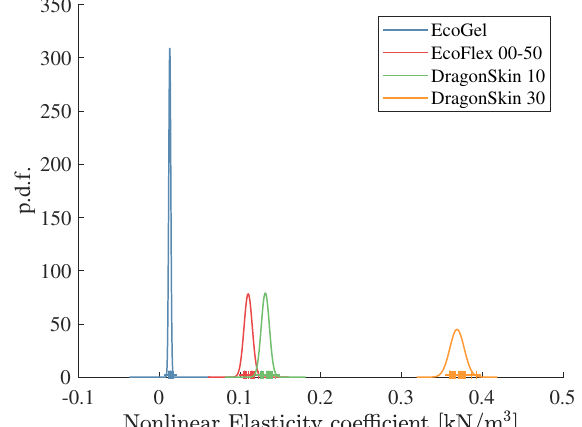
Figure 5. Estimation of the nonlinear elasticity coefficients k nl in model (4) for the four different rubber samples and their normal probability density